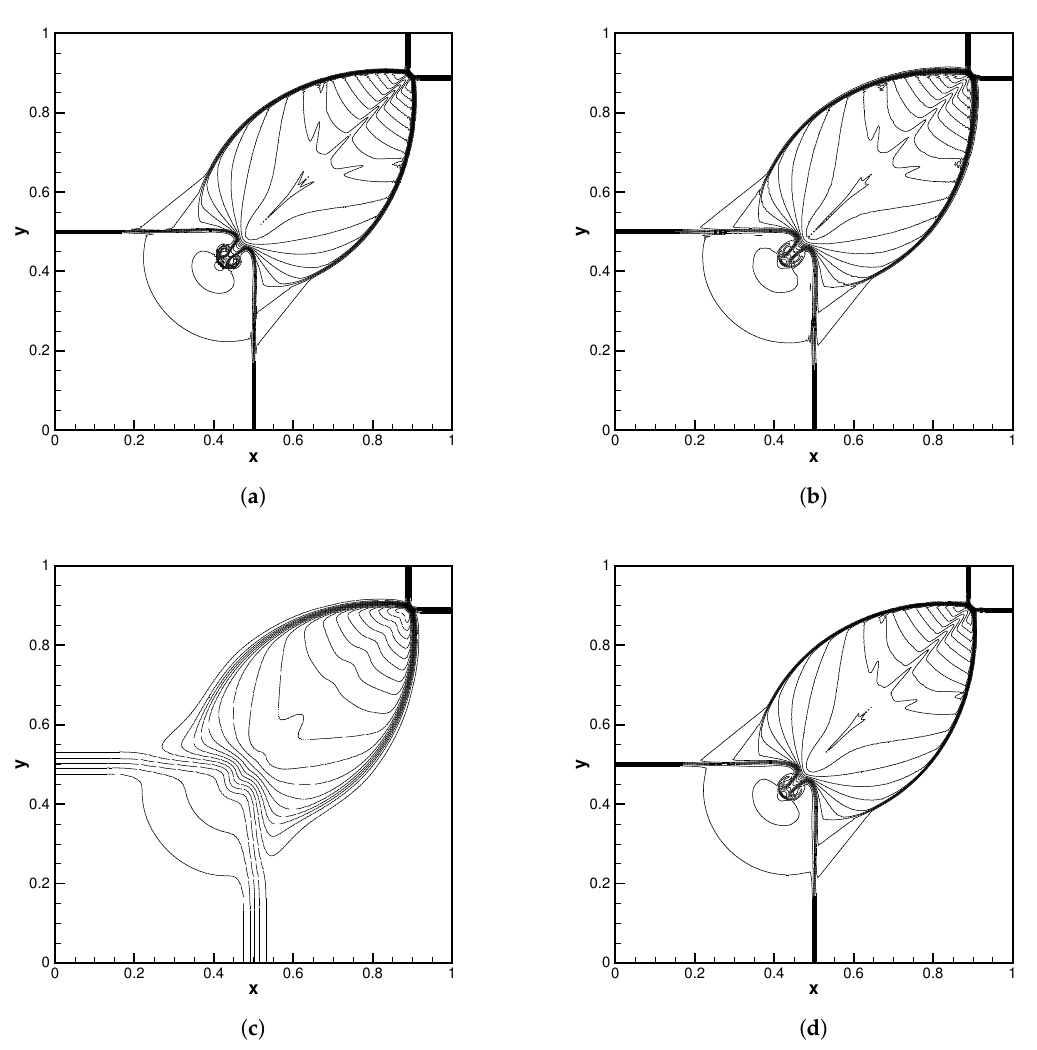
Figure 18. Density solution for the two-dimensional Riemann problem (Case 12) with 160 × 160 P 2 elements at t = 0.25. Thirty-one equally spaced contours from 0.515 to 1.665. ( a ) DB; ( b ) MDH; ( c ) MDA; ( d )